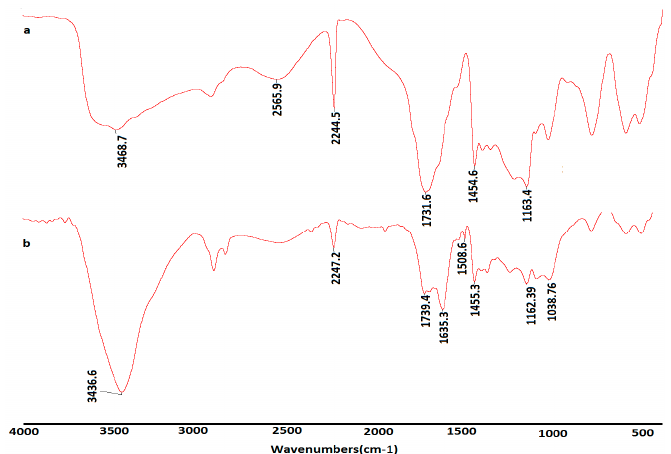
Figure 1. FTIR spectra of β -CD(AN- co -AA) ( a ) and β -CD(AN- co -AA)-Th 4+ ( b ).